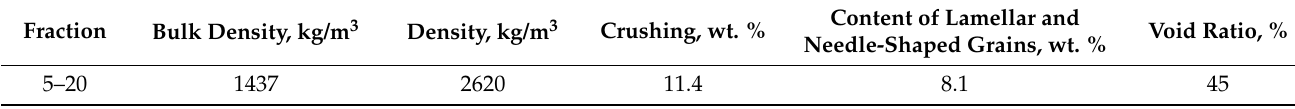
Table 2. Physical and mechanical characteristics of crushed stone.